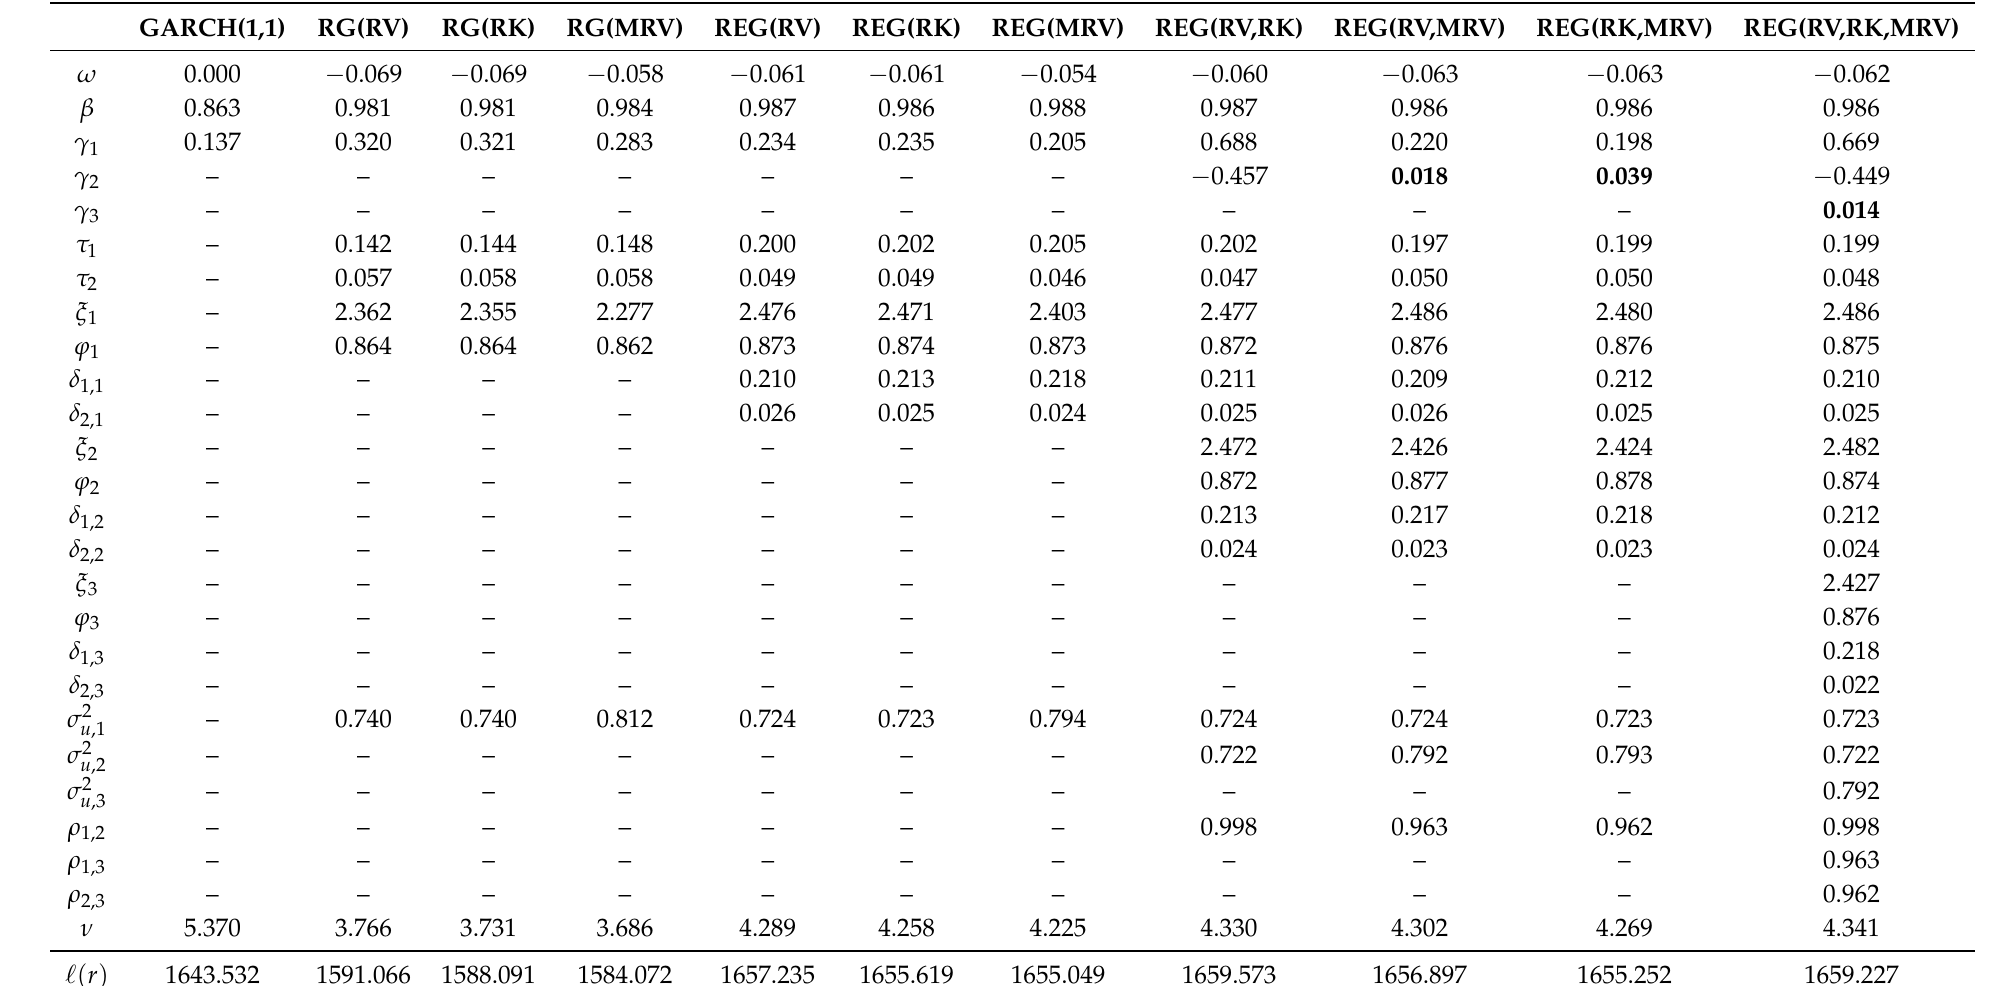
Table 2. NSW in-sample parameter